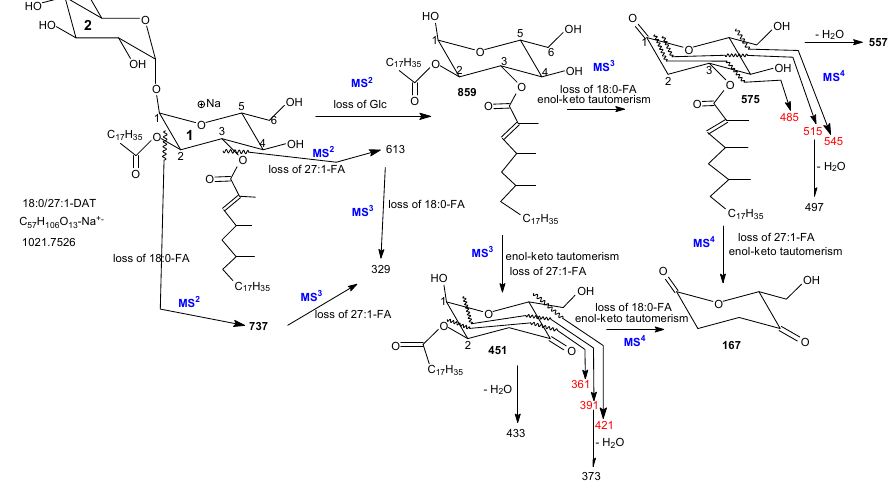
Scheme 1. The structure of [M + Na] + ion of 18:0/27:1-DAT at m/z 1021 and proposed LIT MS n fragmentation processes*. * All the ions represent the sodiated species. To simplify, the drawing of “Na + ” is omitted from the scheme.